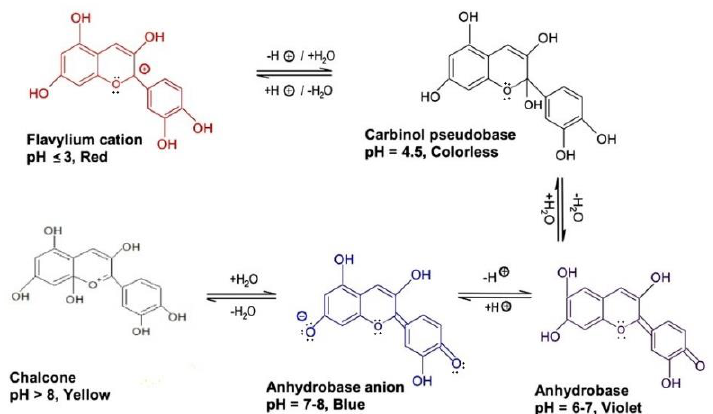
Figure 2. A pictorial description of the pH effect on ACN color stability; changes in ACN color pigments due to the chemical alteration in nitrogenous compounds under various pH conditions.